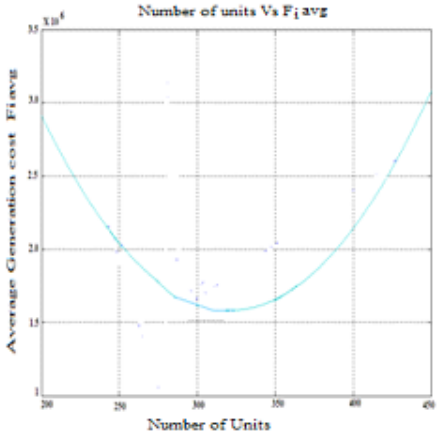
Figure 2. Number of units versus average generation cost